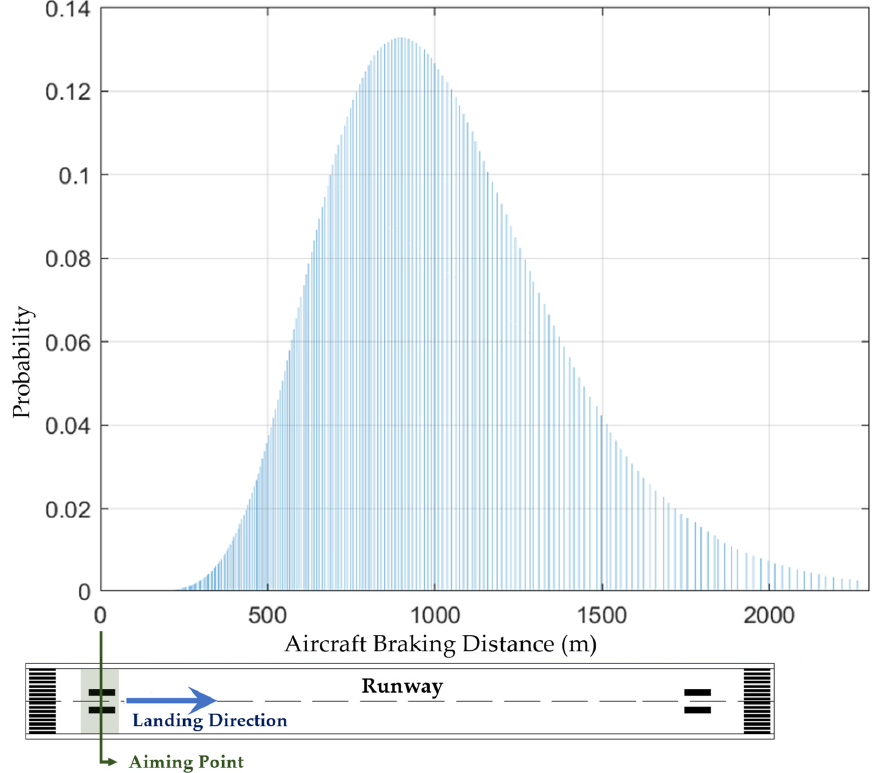
Figure 7. Probability distribution of the braking distances of Boeing 757–300, projected on a 2000 m runway.